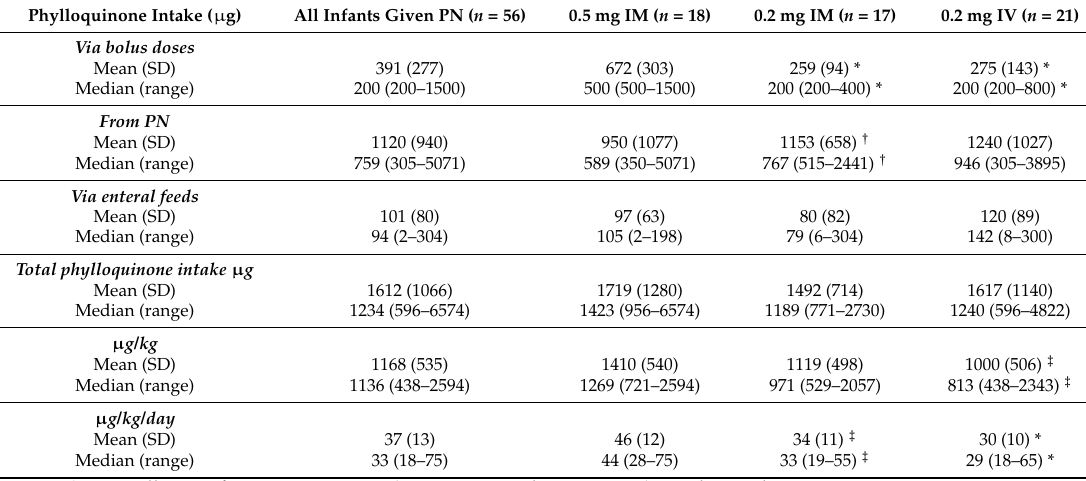
Table 4. Relative intakes of phylloquinone from all sources together with total intakes at study completion in infants who received parenteral